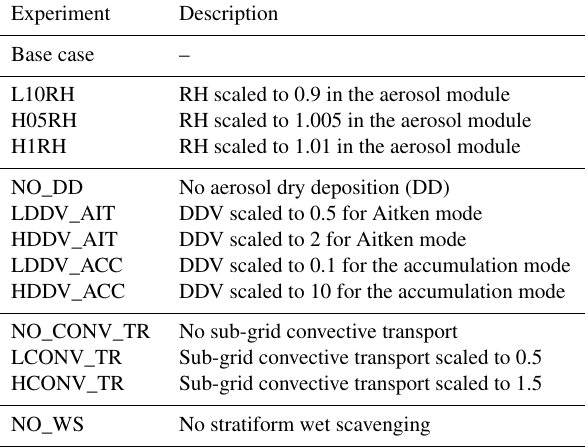
Table 2. Description of the experiments carried out to perform the sensitivity tests of aerosol to different processes; changes of rel- ative humidity (RH), dry deposition (DDV), convective transport, and wet